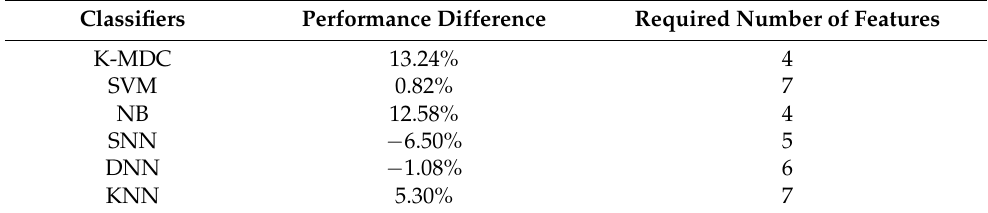
Table 4. Performance difference with or without feature selection methods and required number of features for the detection accuracy to converge, where the convergence is defined as less than 3% from the optimal accuracy.